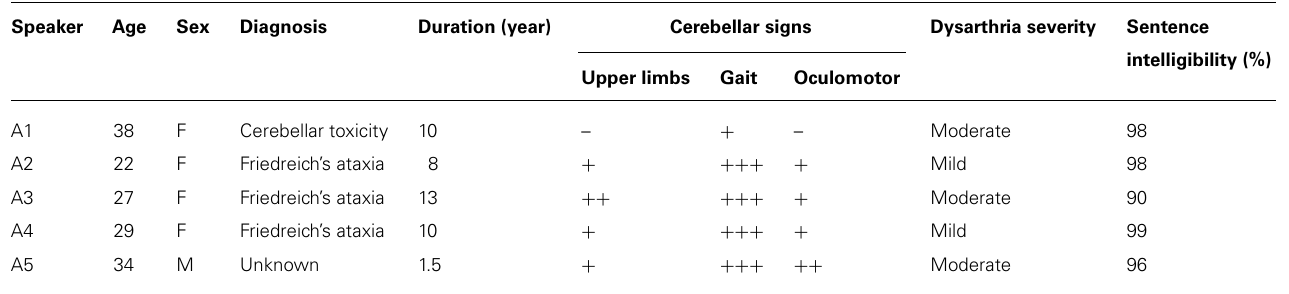
Table 1 | Clinical characteristics of participants with ataxic